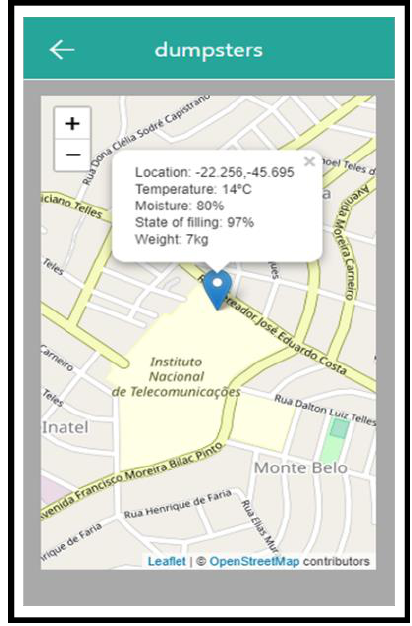
Figure 6. Image of My Waste App.